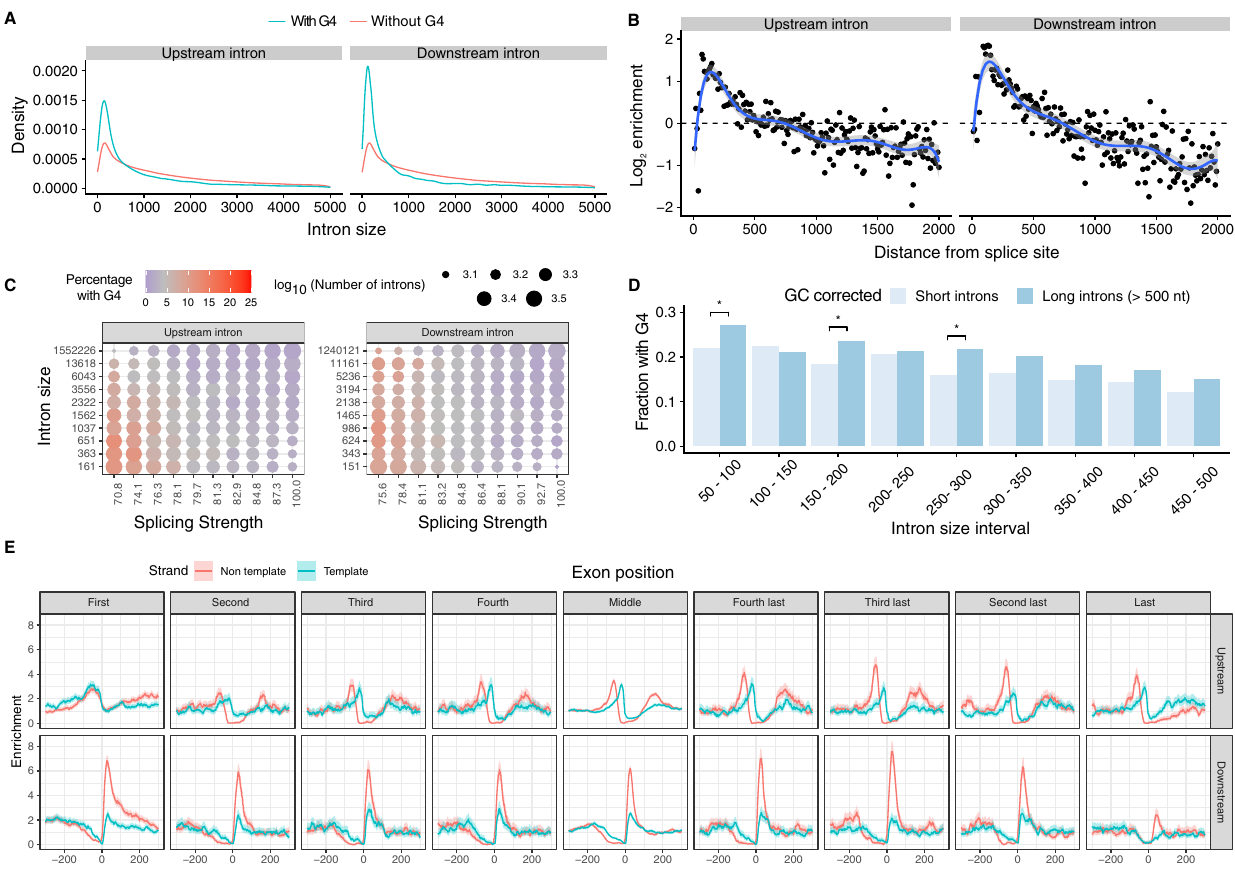
Fig. 3 Distribution of DNA G4s in the vicinity of splicing sites. A Length density distribution of introns upstream and downstream from exons that are fl anked or not by G4s (two-sided Kolmogorov – Smirnov test p value <0.001). B Abundance enrichment of intron sizes at upstream and downstream splice sites fl anked by G4s. A bin size of 10 bps was used with the blue line representing an eighth-degree polynomial model. Error bands represent 95% con fi dence intervals of the regression model. C Heatmap for the relationship between splicing strength score, intron length and G4 presence in a local window of 100 nt within the splice site for the upstream and downstream introns. Red colour represents a high proportion of splice site regions with G4s, whereas blue colour represents depletion of G4s. D Fraction of splice sites with a G4, controlling for GC content between long and short introns. We use chi-squared test to evaluate signi fi cant differences between short and long introns (* denotes p values <0.05 after multiple testing corrections). E G4 motif enrichment relative to the splice site across exons in the gene body at the 3 ′ ss and at the 5 ′ ss for template and non-template strands. G4 motifs are enriched at both 3 ′ ss and 5 ′ ss across splice sites throughout the gene body. Exons were separated into fi rst to fourth exons, middle exons, last four exons and the distribution of G4s were studied individually for each category. Error bands represent 95% con fi dence intervals based on the binomial